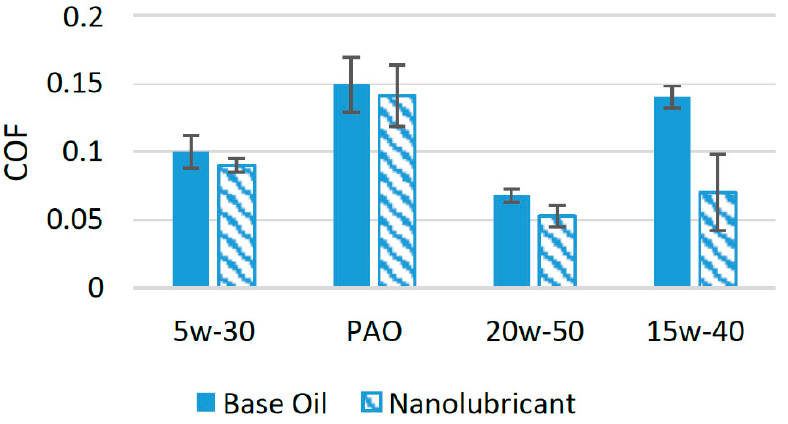
Figure 7. Effect of h-BN NPs on the friction performance of synthetic lubricants.